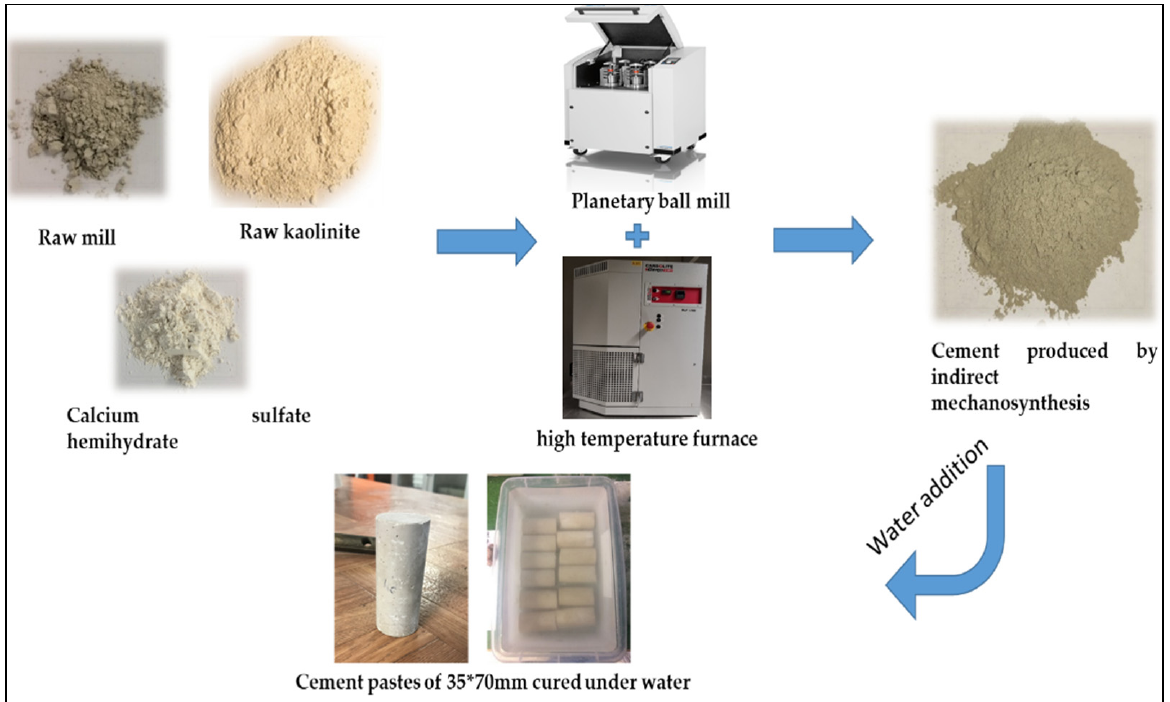
Figure 2. Process of production of cement by indirect mechanosynthesis.